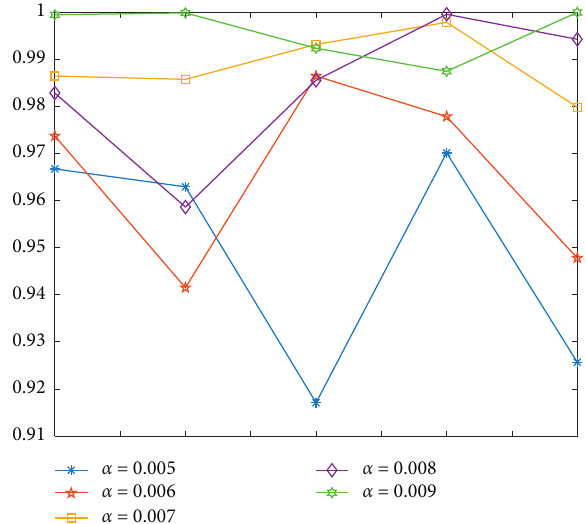
Figure 4: Relationship between node density and coverage ( r � 15).